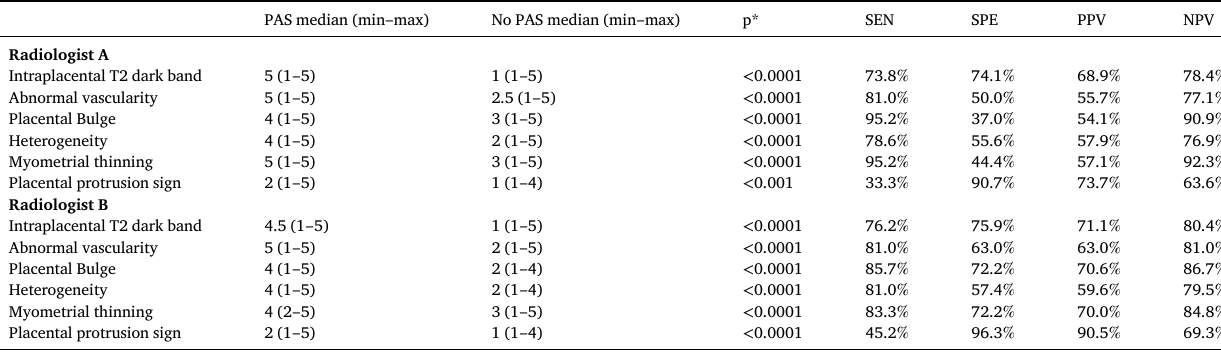
Table 3 MRI feature analyses and performance for each radiologist.